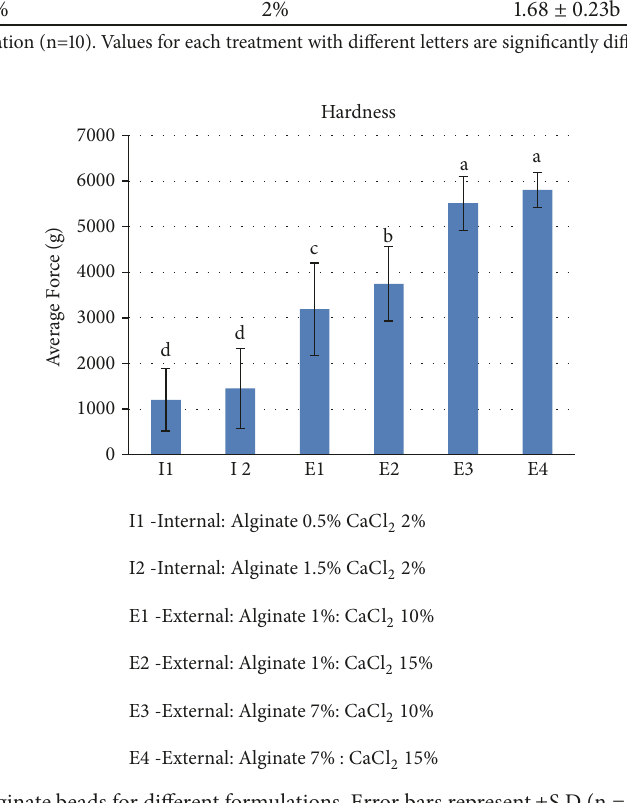
Figure 3: Hardness of spirulina-alginate beads for different formulations. Error bars represent ± S.D (n = 30). The bars with different letters are significantly different ( 𝛼